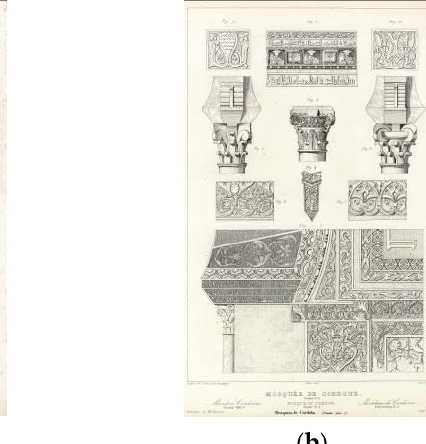
Figure 12. Girault de Prangey: ( a ) General plan and section and details from the Mosque (Jourdan, dib.; Bury, eng.); ( b ) Mosque details (Prangey, dib.; Niel, dib.; Bury, eng.). Source: Monuments anciens et modernes... c. 1845.